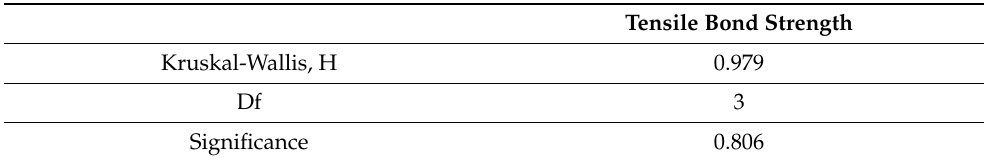
Table 9. Kruskal–Wallis test statistic result for the influence of the amount of addition (% of lime solution) on the tensile bond strength.